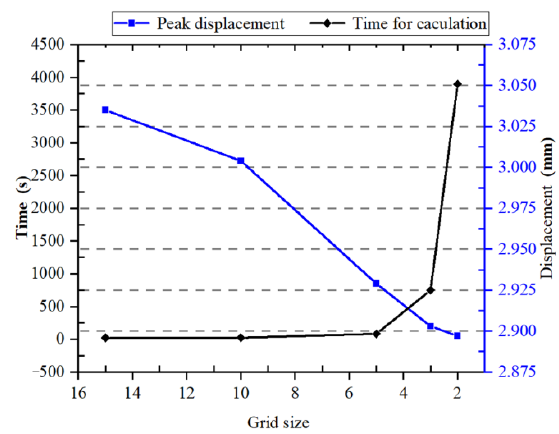
Figure 4. Tensile stress–strain curves of LGF/PP.